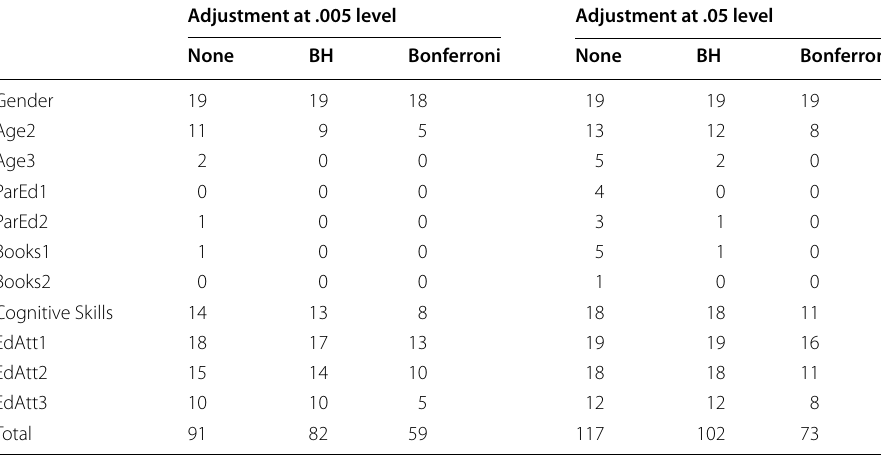
Table 6 Counts of discoveries for M3 coefficients, by variable [Q1] Adjustment at .005